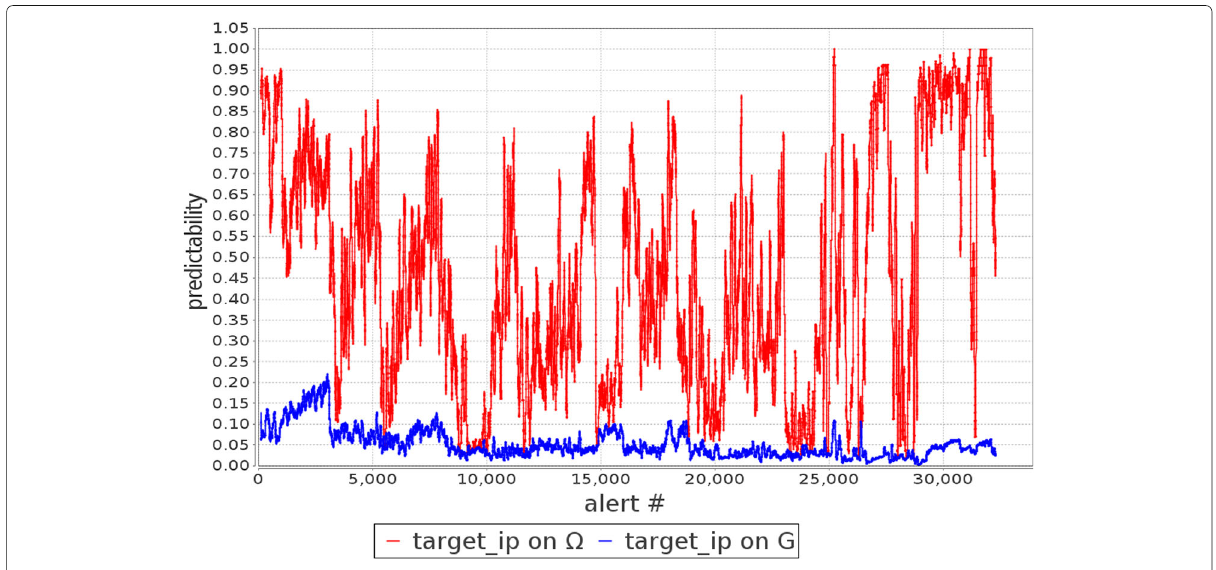
Fig. 6 The ˜ p n ((cid:2)) and ˜ p n ( G ) for target IP as the alerts come into the system